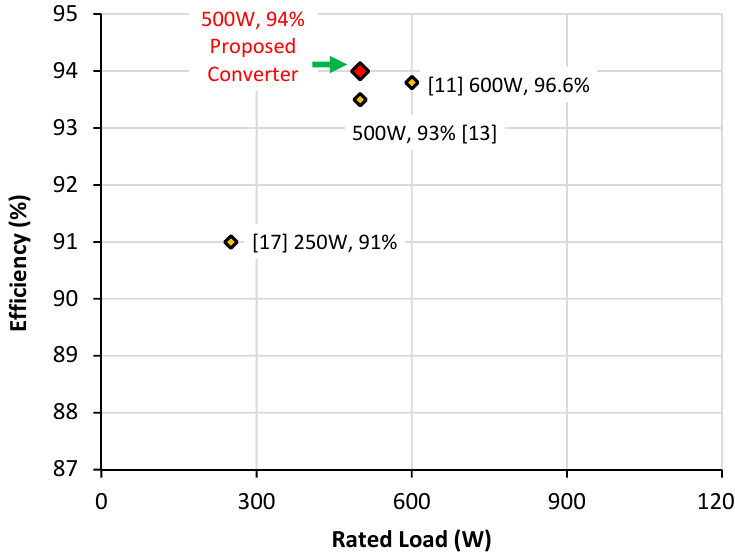
Figure 20. Scatter plot between calculated efficiency and rated load for comparing the proposed and conventional MPCs.